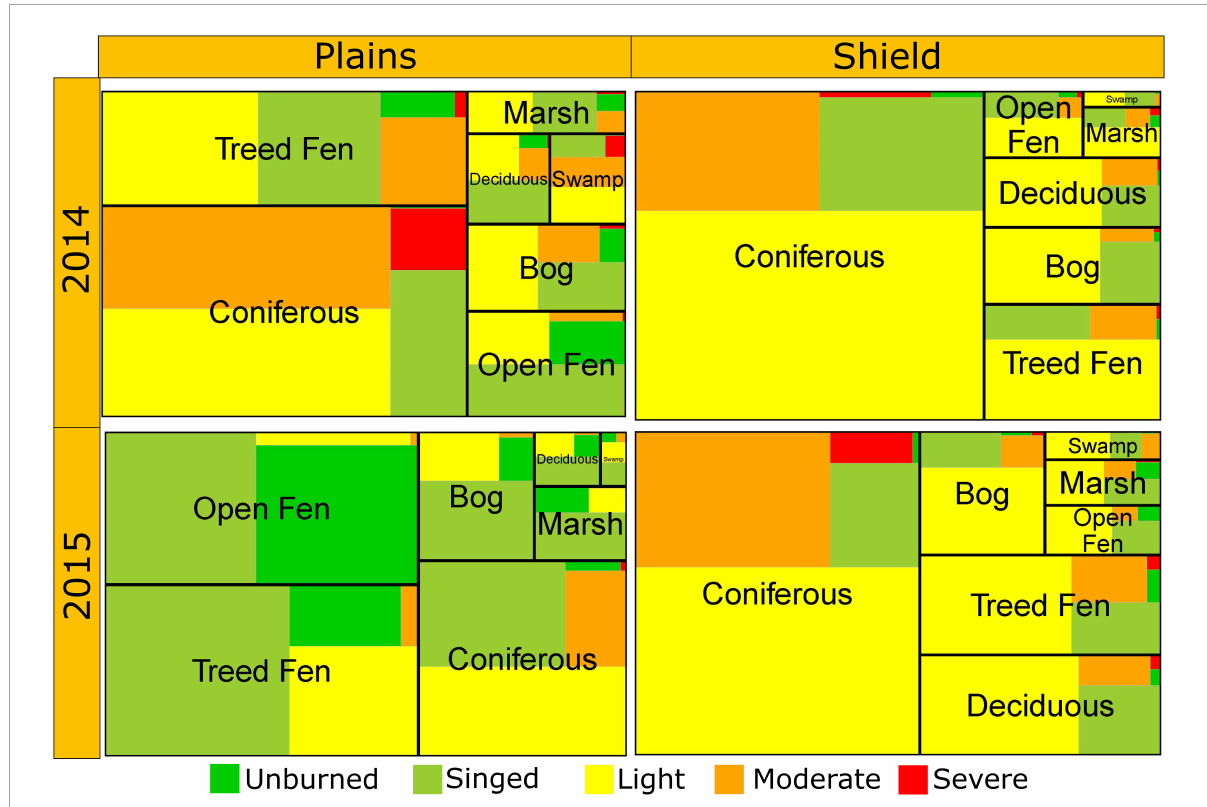
FIGURE9 Treemap where the area of each box represents the proportion of that respective class and class/severity combination resulting from the intersection of the ecosystem and burn severity layers for Taiga shield (right column) vs. Taiga plains (left column) in 2014 (top row) vs. 2015 (bottom row) . The area of each ecosystem type box is proportional to the area within the fire perimeter and area of each embedded colored burn severity class is proportional to the area within the